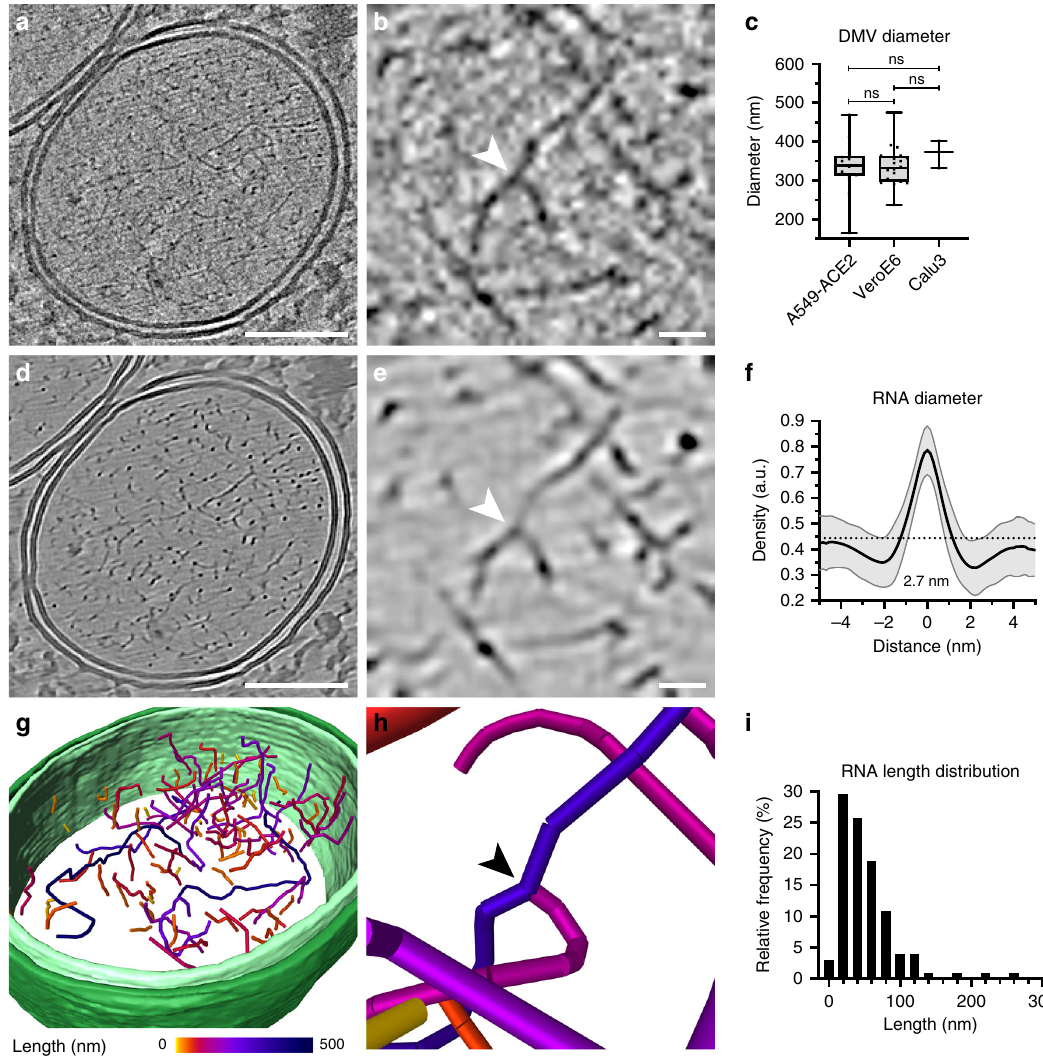
Fig. 1 Spatial distribution and length of RNA fi laments. a Slice of a SIRT-like fi ltered tomogram of an A549-ACE2 cell infected with SARS-CoV2 showing a DMV. b Magni fi ed slice of a tomogram (1.3 nm thick) showing RNA fi laments and a branching point (arrowhead) in detail. c Distribution of DMV inner membrane diameter in three different cell lines (A549-ACE2: n = 14; VeroE6: n = 20; Calu3: n = 3). Data is shown as Box and Whiskers plots indicating the median (center of box), 25% and 75% quartiles (bounds of box), minimum and maximum values (bars), and all data points. Unpaired two-sided t -test showed no signi fi cant differences between the diameter of DMVs found in the three different cell lines. d , e Tomogram slices shown in a and d after content-aware denoising using cryo-CARE 48 . f Average normalized density line pro fi le of fi lament cross-sections. The indicated error band shows the SD ( n = 80 from two tomograms), the average gray value of the DMV interior is shown as dotted line (0.44 arbitrary units). g , h Manual segmentation of the denoised DMV (Supplementary Movie 1), inner and outer membrane are represented in light and dark green, respectively. Individual segmented fi laments are colored according to their length and a branching point is indicated by an arrowhead in the magni fi ed segmentation image (h). i Histogram of RNA length ( n = 101) with a bin size of 20 nm. Branched fi laments were measured individually. Bicubic interpolation was applied for image smoothing in b and e . Scale bars: a , d 100 nm; b , e 10